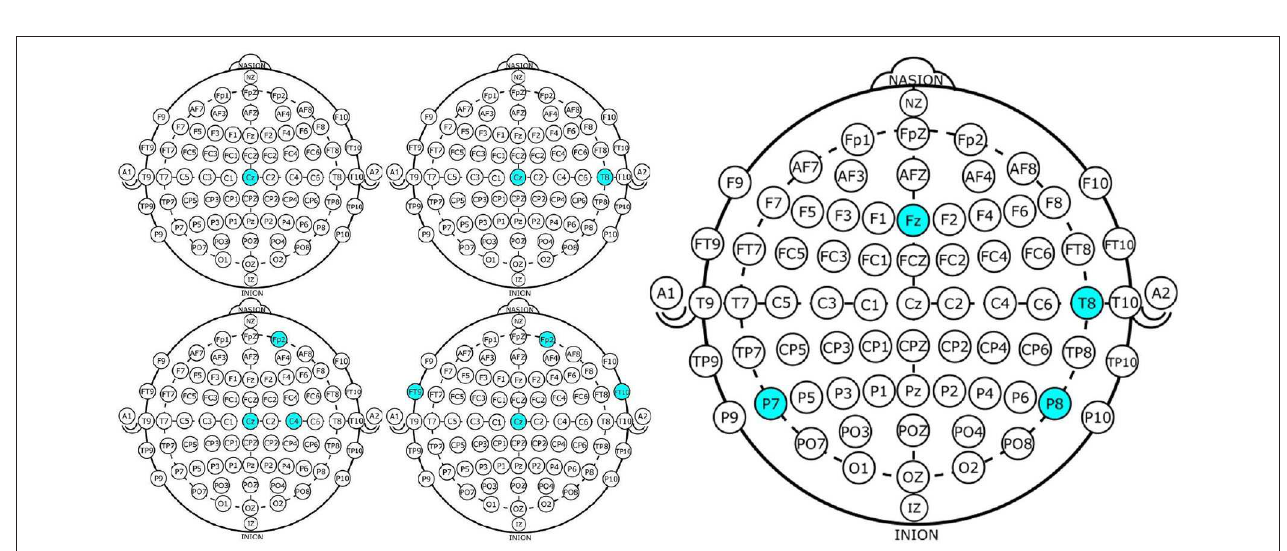
FIGURE 4 | Four EEG Channel subsets selected by NSGA-II (left) and backward-elimination (right) for epileptic-seizure classification in patient 1.